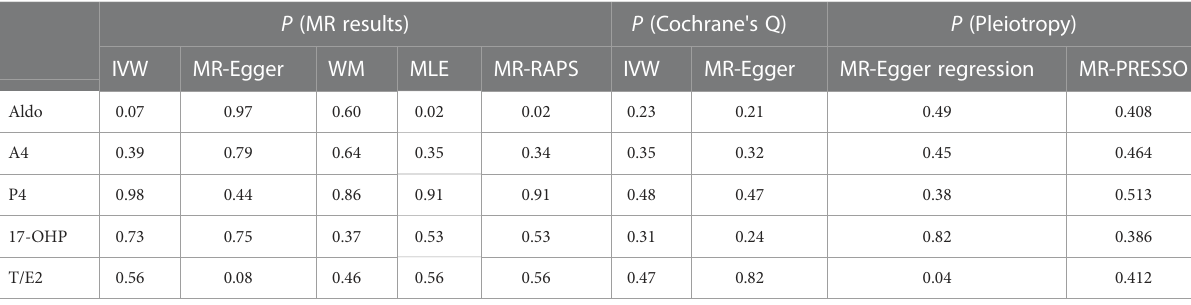
TABLE 3 MR results and sensitivity analyses between steroid hormones and DR in the discovery stage. P (MR results) P (Cochrane's Q) P (Pleiotropy)